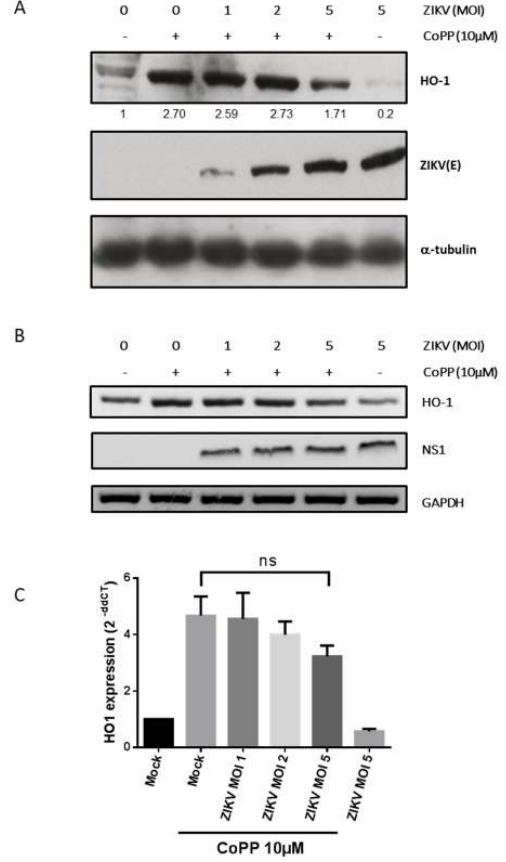
Figure 4. ZIKV infection decreases HO-1 induction mediated by CoPP at the protein and the mRNA levels. A549 cells were infected with ZIKV-PF13 at several multiplicity of infection (MOI) and then treated 2 h post-infection with CoPP for 16 h. In ( A ), HO-1 and ZIKV-E protein expression were analyzed by Western blot using anti-HO-1 and anti-ZIKV-E 4G2 antibody. Antibody against α -tubulin served as protein loading control. Quantification was done with the ImageJ software. In ( B ), HO-1, ZIKV NS1 and GAPDH mRNA expression were analyzed by RT-PCR. In ( C ) RT-qPCR analysis of HO-1 expression. ns = not significant.